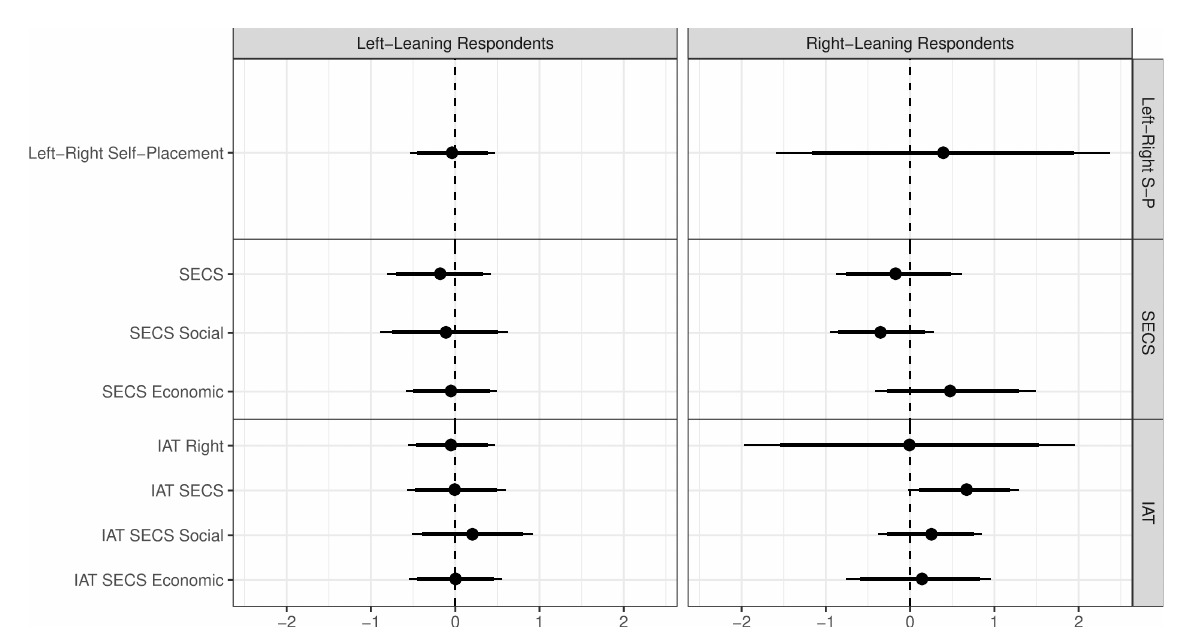
FIGURE 6 Effects of anxiety on measures of political attitudes in subgroups based on pre-existing political attitudes as Cohen‘s d effect sizes. Positive values imply that average political attitudes under threat are more conservative than those under safety. Thin (thick) bars show the 95% (90%) bootstrap BCa confidence intervals. The pooled standard deviation was used for the calculation. IAT, Implicit Association Task; SECS, Social and Economic Conservatism Scale. N varies per subgroup and measure; see also section Data recording and preparation (left panel: N = range: 31–61; right panel: N = range: 7–42).